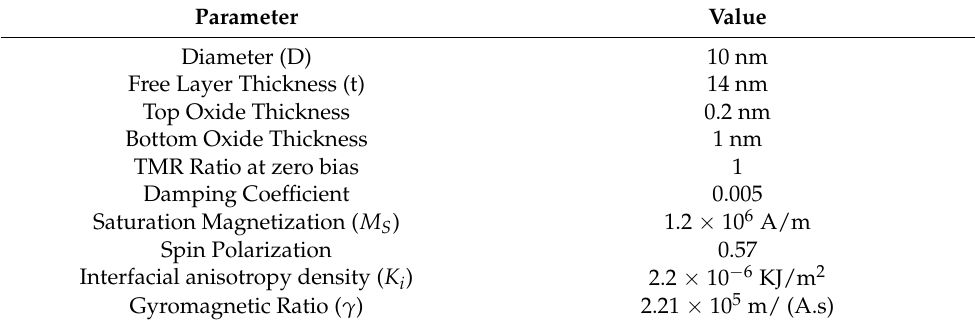
Figure 4. Variation of ( a ) transient parameters vs. bottom oxide thickness; ( b ) eye parameters vs. bottom layer thickness; ( c ) oxide resistance vs. top layer thickness; ( d ) thermal stability factor vs. free layer thickness. Table 1. s-PMA DMTJ parameters used for designing a logic locking